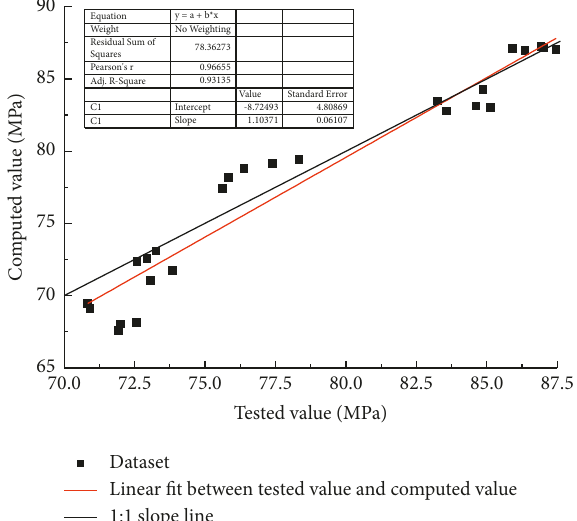
Figure 17: Cross-correlation of tested and computed values from damage variable on ( W ) .